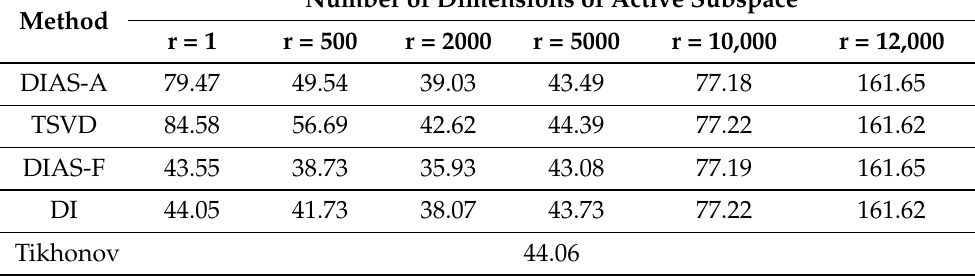
Table 10. Relative error (%) of inverse solutions by DIAS and Tikhonov regularization for underregu- larization case with α = 1.35 × 10 5 , noise level 5%.